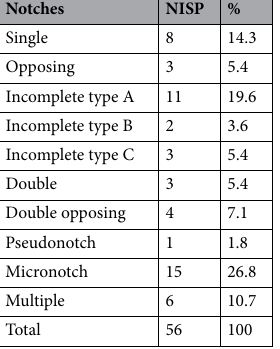
Table 5. Evidences of notches observed in VM4.